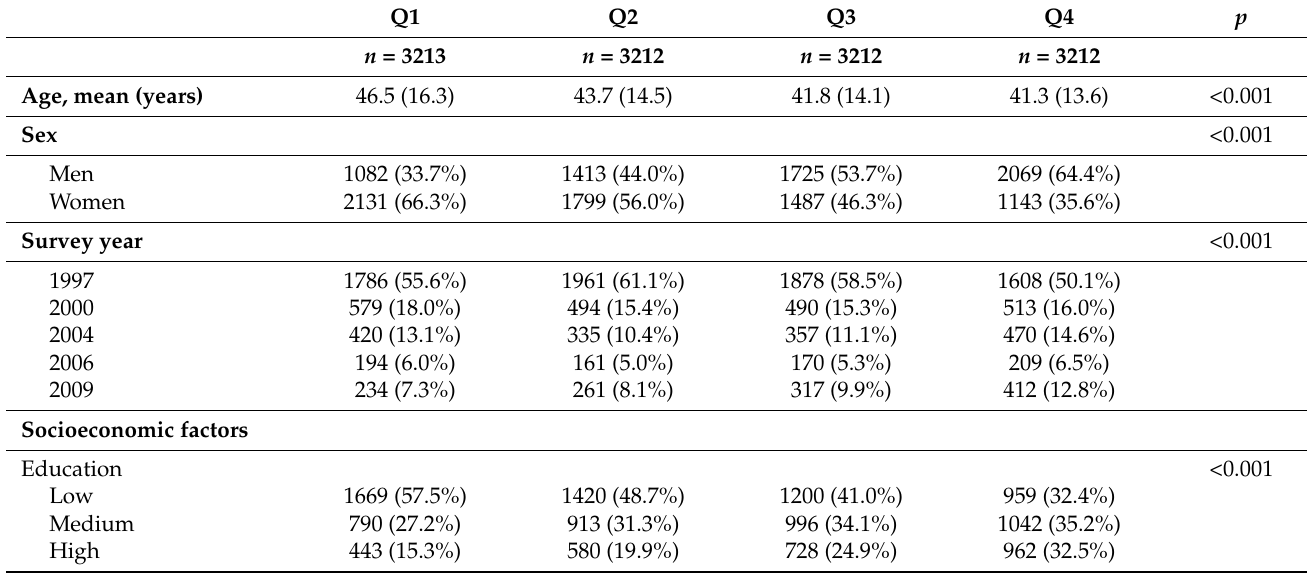
Table 1. Sample characteristics of Chinese adults aged ≥ 20 years old who completed at least two nutrition surveys in the China Health and Nutrition Survey during 1997–2011 by quartiles of methionine intake ( n =